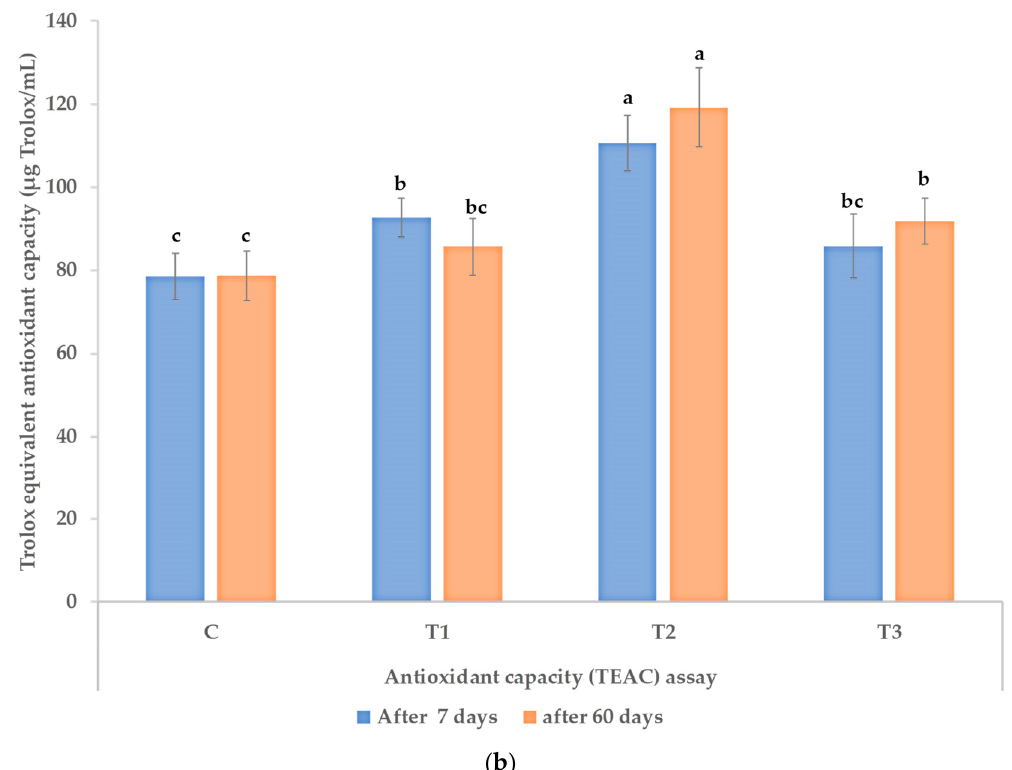
Figure 5 . Antioxidant activity of the hydroalcoholic extract of aerial parts of the P. caerulea plants, Figure 5. Antioxidant activity of the hydroalcoholic extract of aerial parts of the determined as the ability to scavenge the formation of the DPPH (2,2-diphenyl-1-picryl-hydrazyl- P. caerulea plants, determined as the ability to scavenge the formation of the DPPH hydrate) free radicals ( a ) and TEAC (Trolox equivalent antioxidant capacity) ( b ), after seven days (2,2-diphenyl-1-picryl-hydrazyl-hydrate) free radicals ( a ) and TEAC (Trolox equivalent antioxidant from the first treatment and after 60 days from the first treatment. C—control (no treatment with plant capacity) ( b ), after seven days from the first treatment and after 60 days from the first treatment. biostimulants, treatment only with water); T 1 —foliar treatment with the Trichoderma consortium C—control (no treatment with plant biostimulants, treatment only with water); T 1 —foliar treatment suspension, 10 6 cfu/mL, equiv. to 10 11 spores/ha; T 2 —foliar treatment with the Trichoderma consortium suspension, 10 8 cfu/mL, equiv. to 10 13 spores/ha; T 3 —foliar treatment with a reference product, consisting of plant extracts, essential oils and fatty acids in an oil/water emulsion, and extract of the seaweed Ascophyllum nodosum , equiv. to 3 L/ha. The values presented are means ± standard error ( n means ± standard error ( n = 12 replicates). Columns labeled with di ff erent letters, compared between = 12 replicates). Columns labeled with different letters, compared between the different treatments the di ff erent treatments (C, T1, T2, and T3) within each time period (after 7 days and, respectively, (C, T1, T2, and T3) within each time period (after 7 days and, respectively, after 60 days) are significantly different at p < 0.05.